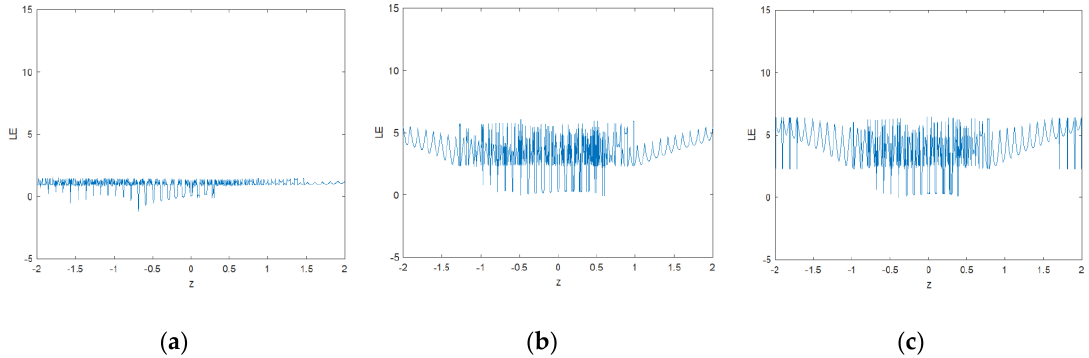
Figure 5. Lyapunov map of fractal images generated from: ( a ) MS function; ( b ) CFF with 𝛽 = 0.3; ( c ) CFF with 𝛽 = 0.5.